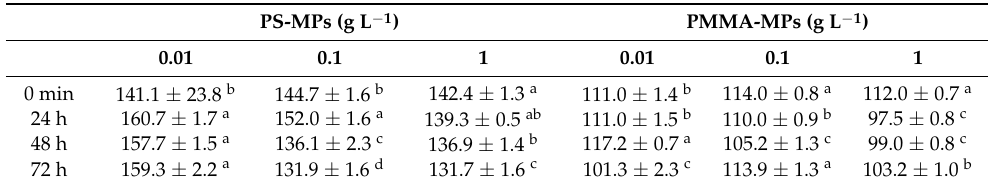
Table 1. Temporal analysis of changes in hydrodynamic diameter (d H ) of 0.01, 0.1, and 1 g L − 1 PS-MPs and PMMA-MPs in ultrapure water.